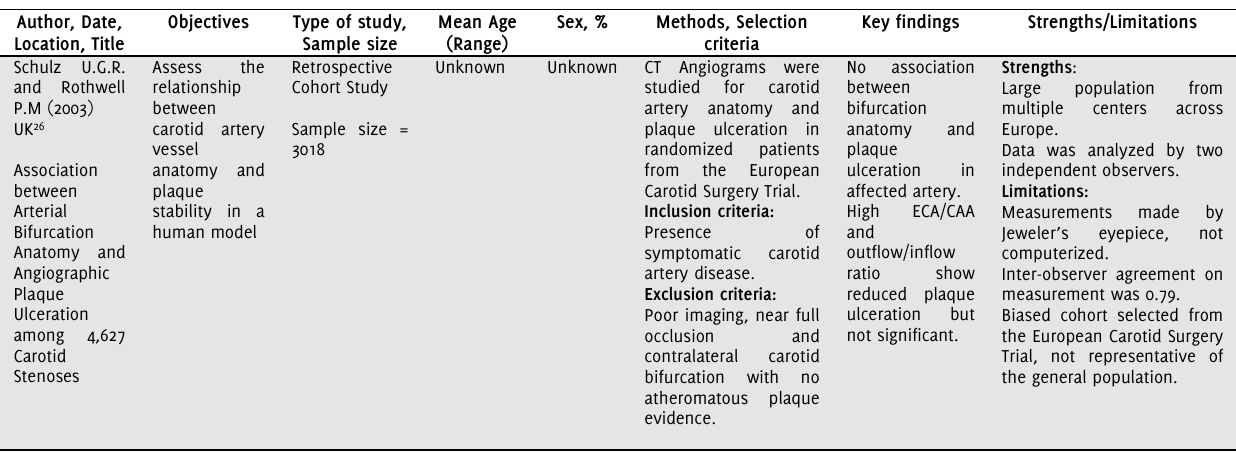
Table 3 . Carotid artery anatomy and the pathogenesis of